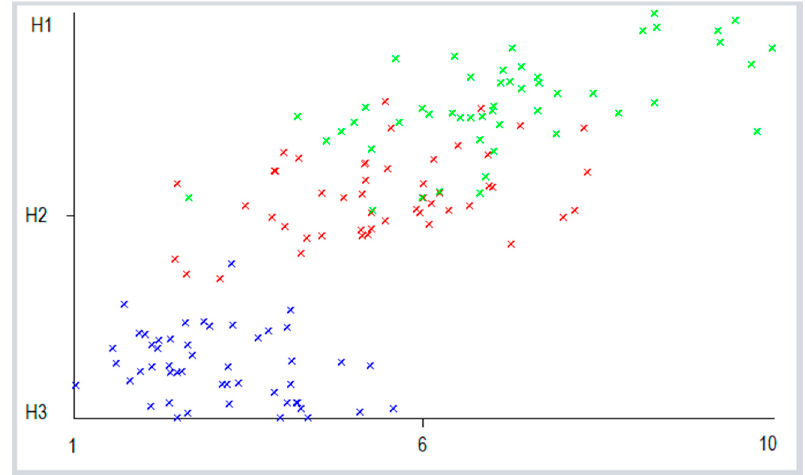
Figure 5. Data analysis of the activities developed in an online education model with the use of big data. H1: Forums, H2: Homework, H3: Evaluations.